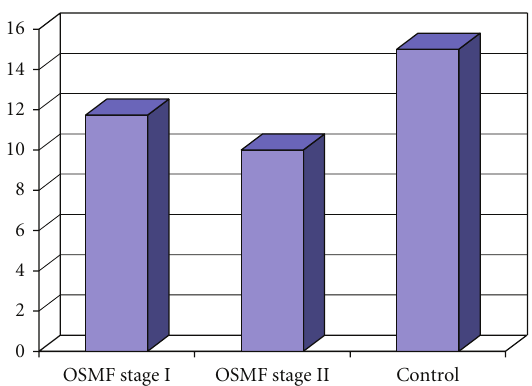
Figure 3: Mean hemoglobin (%) level in OSMF and control groups.